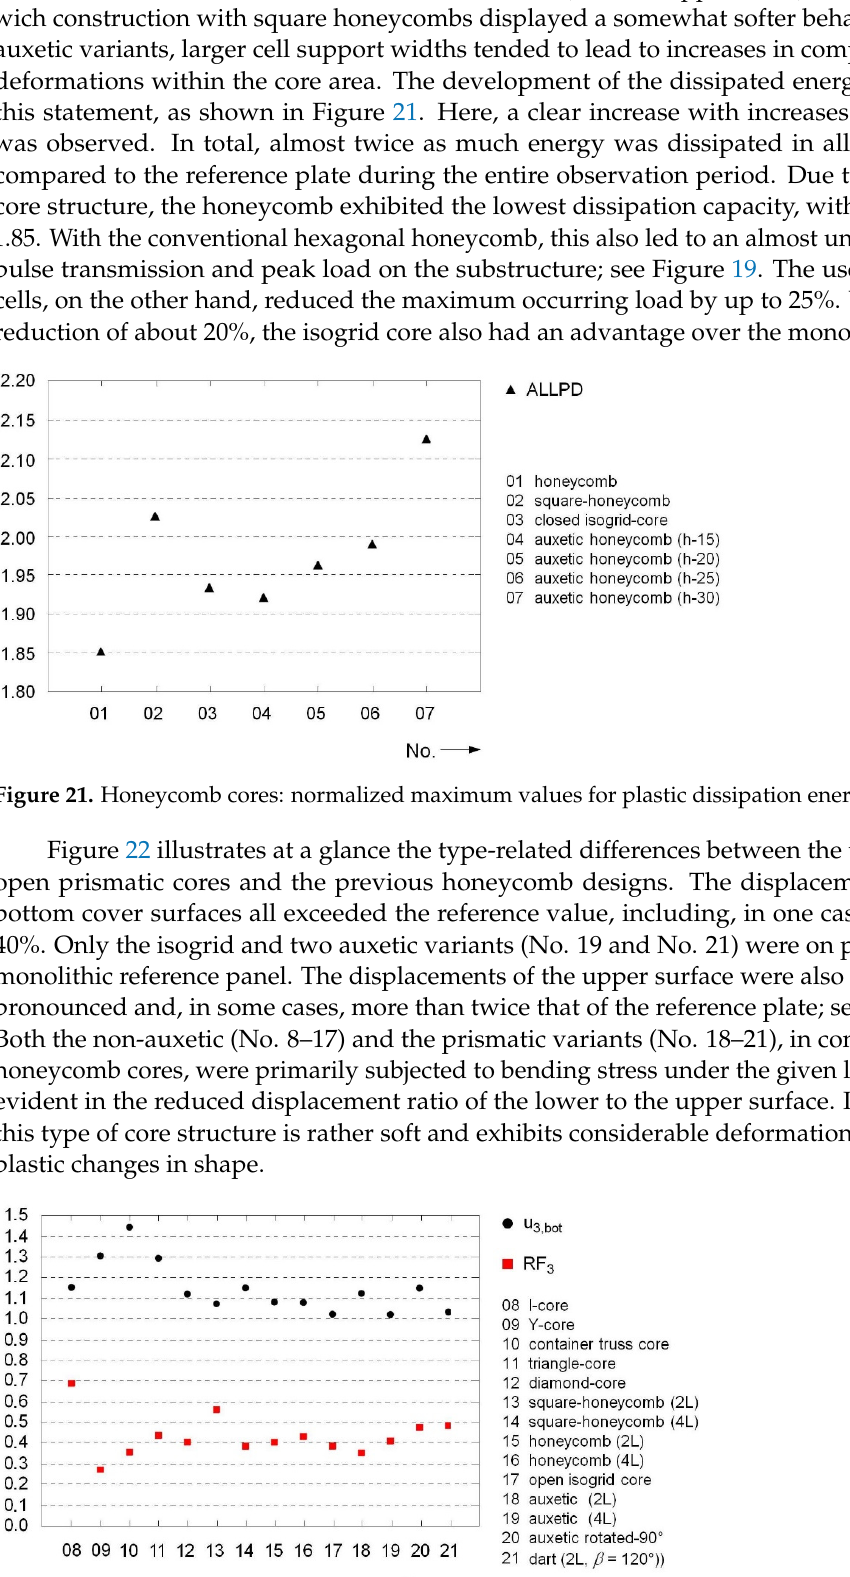
Figure 23. Prismatic cores: normalized maximum values for displacement 𝑢 (cid:2871),(cid:2930)(cid:2925)(cid:2926) and displacement ratio 𝑢 (cid:2871),(cid:2930)(cid:2925)(cid:2926) /𝑢 (cid:2871),(cid:2912)(cid:2925)(cid:2930) . The plastic energy dissipations are correspondingly higher. With factors between 2.8 and 3.1, the prismatic variants not only surpassed the performance of the reference panel but also that of the sandwich components with honeycomb cores; see Figure 24. The geometries with the highest residual membrane stiffnesses (I ‐ core and square hon ‐ eycomb 2L/4L) showed significantly lower levels of plastic deformation and, conse ‐ quently, dissipated less energy. Apart from these two geometries, the considered pris ‐ matic core topologies reduced the peak load transmitted to the support structure by about 60% on average, with the Y ‐ core structure reducing it by more than 70%; see Fig ‐ ure 22.